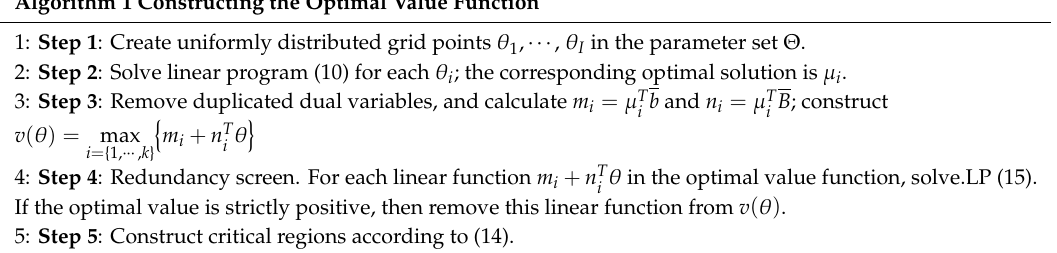
Algorithm 1 Constructing the Optimal Value